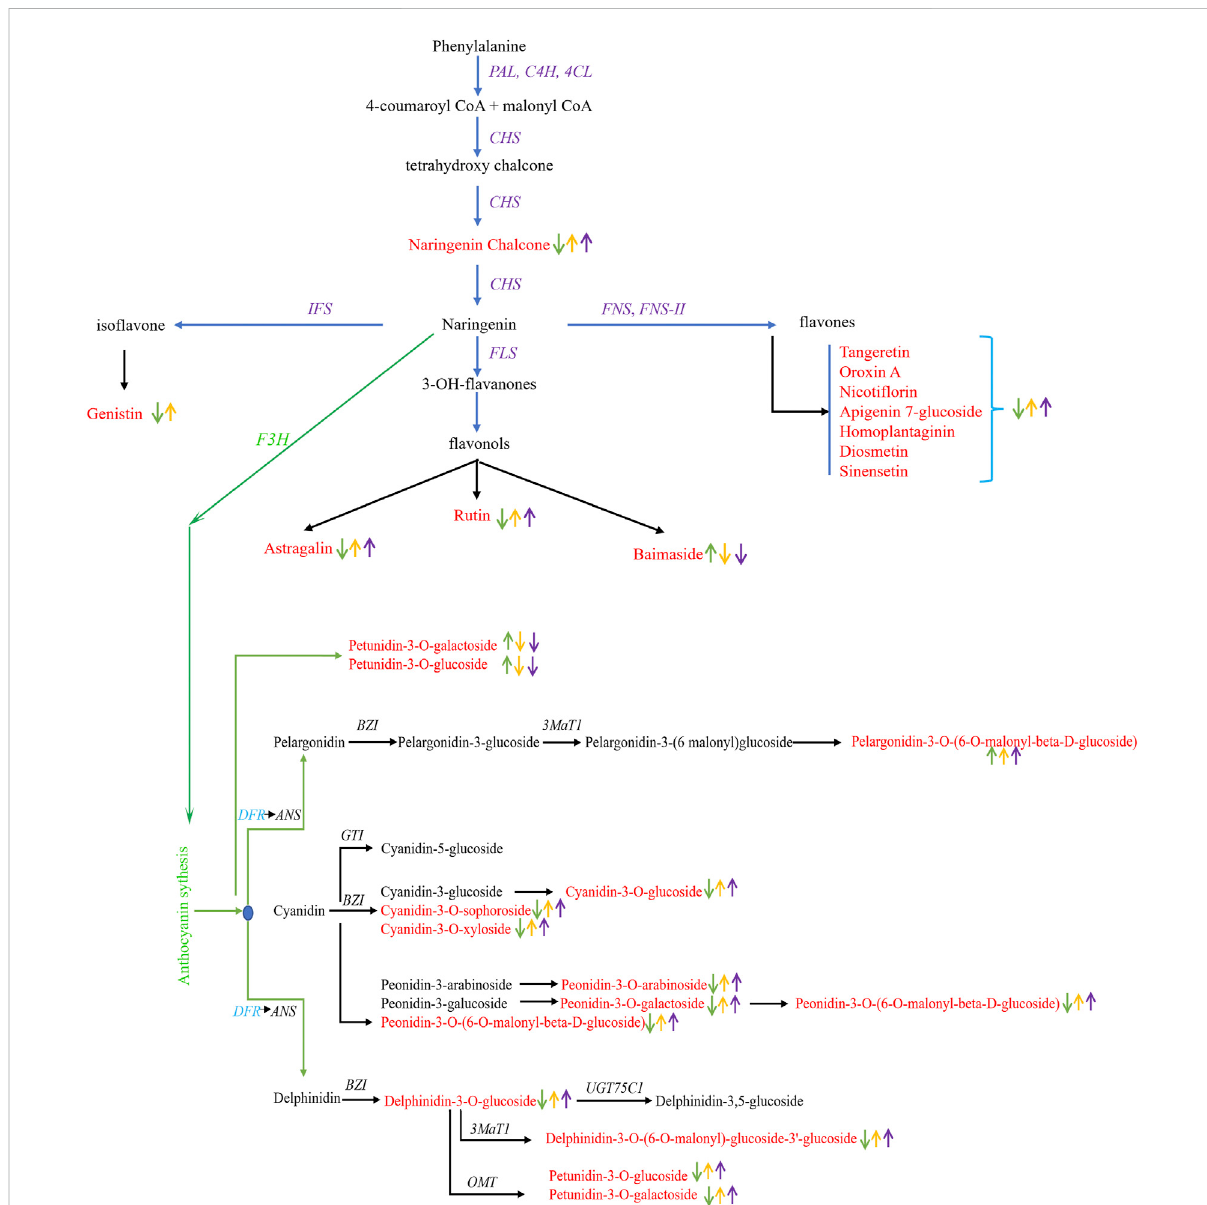
FIGURE 8 Differentialregulationof fl avonoidbiosynthesisin C.ensifolium leaves.Differentiallyaccumulated fl